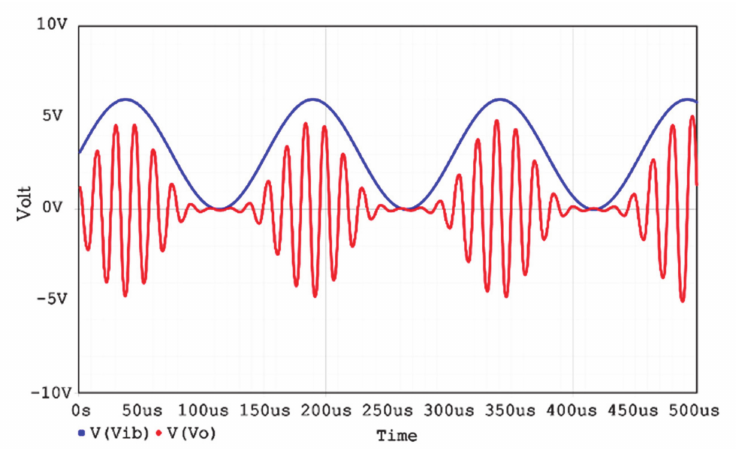
Figure 27. The simulation result of the AM signal generator using sine wave input